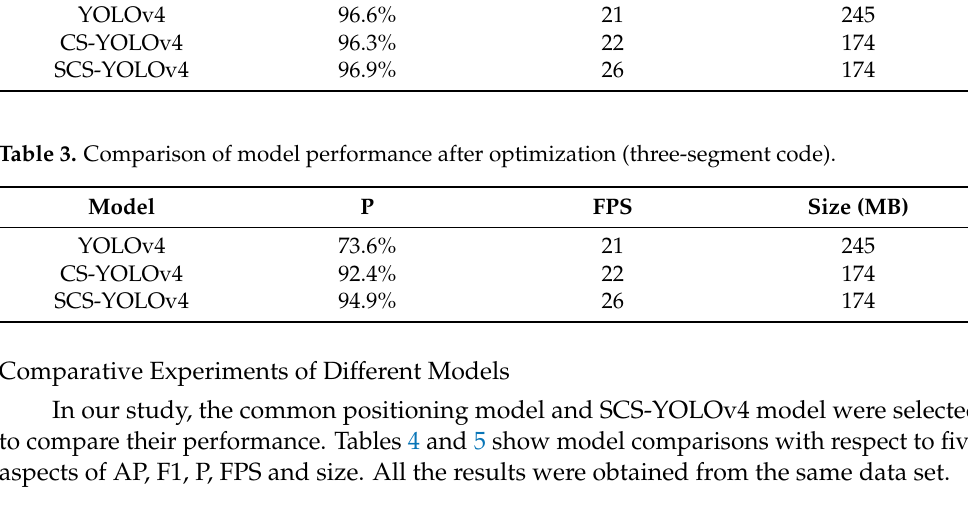
Table 4. Performance comparison of different models (bar code).